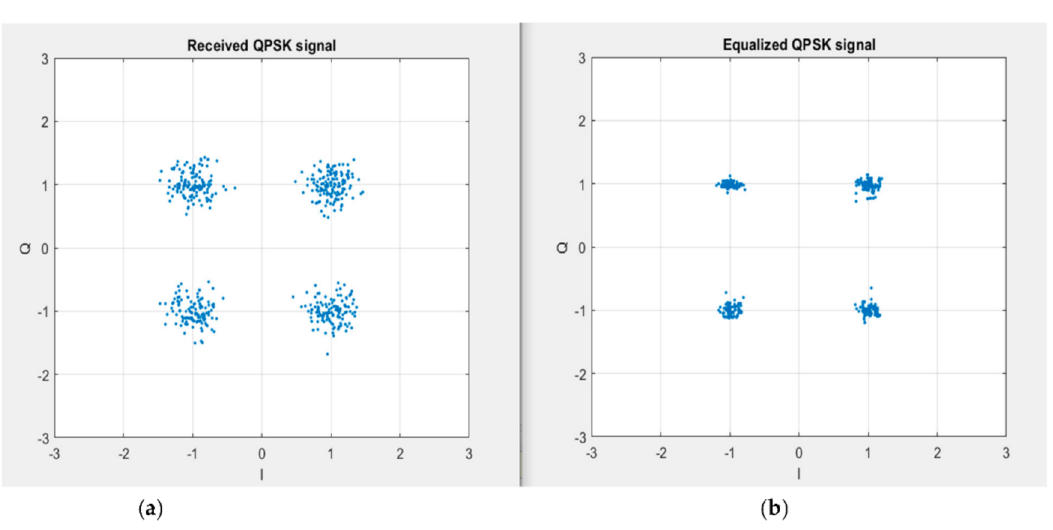
Figure 15. EVM measurements for QPSK modulation using MF equalization (100 km SMF link). ( a ) Constellation diagram for QPSK before equalization with EVM 18.7%. ( b ) Constellation diagram for QPSK after MF equalization with EVM 16.4%.